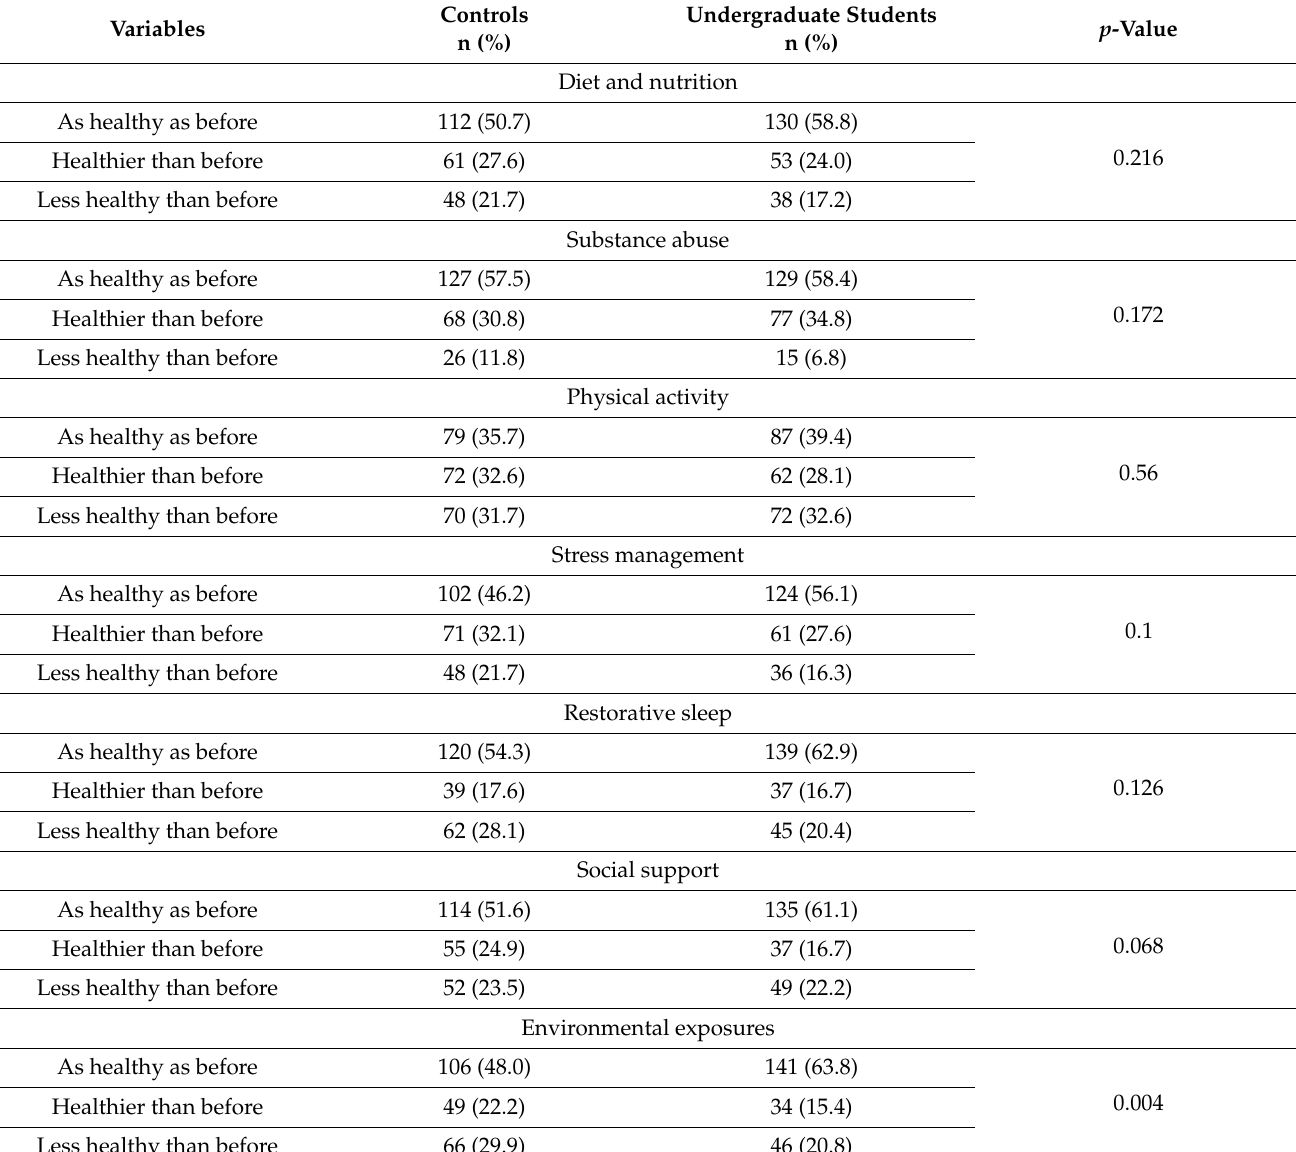
Table 3. Self-reported changes on lifestyle behaviors compared with before the pandemic.